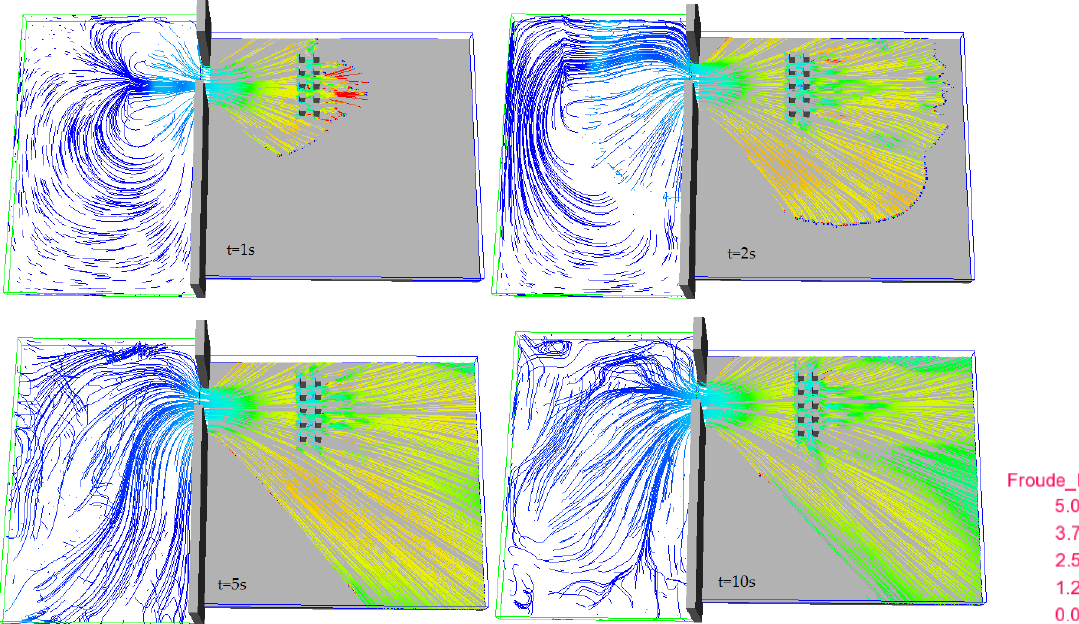
Figure 8. Snapshots of streamlines of Froude number at different times: 1.0 s, 2.0 s, 5.0 s and 10 s.